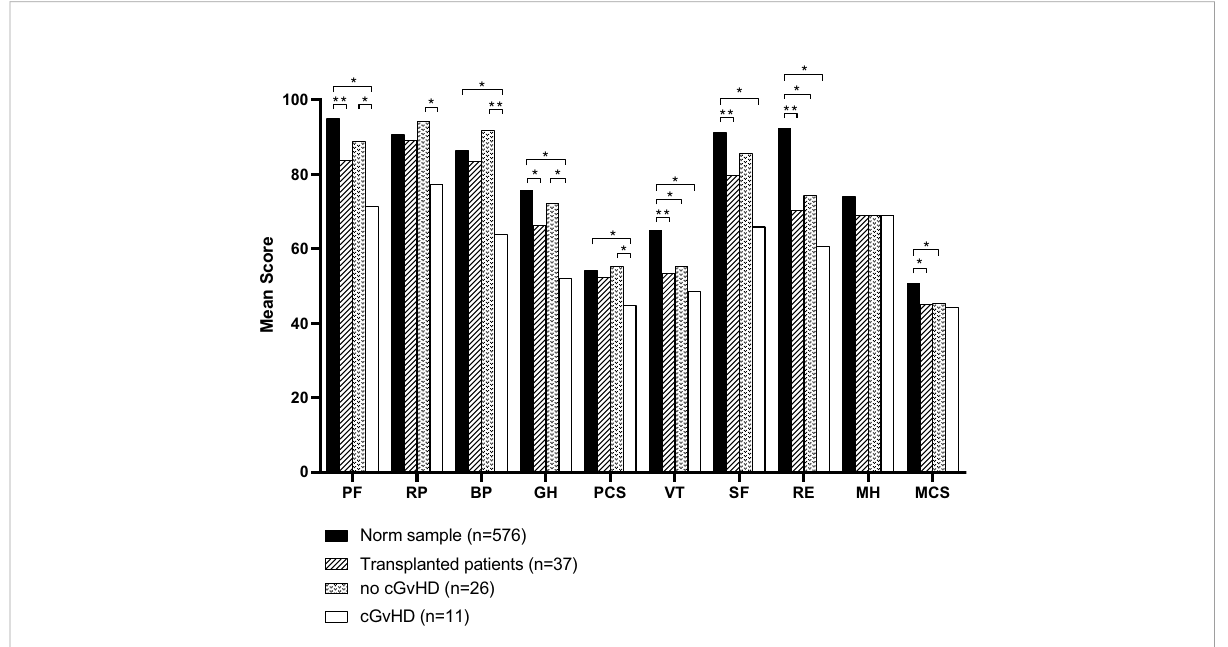
FIGURE 4 Mean scores of all domains assessed by the SF-36 questionnaire compared to the norm sample and separated into participants with or without cGvHD. For abbreviations, see the legend of Figure 6. Levels of signi fi cance are indicated by *denoting p<0.05 and **denoting